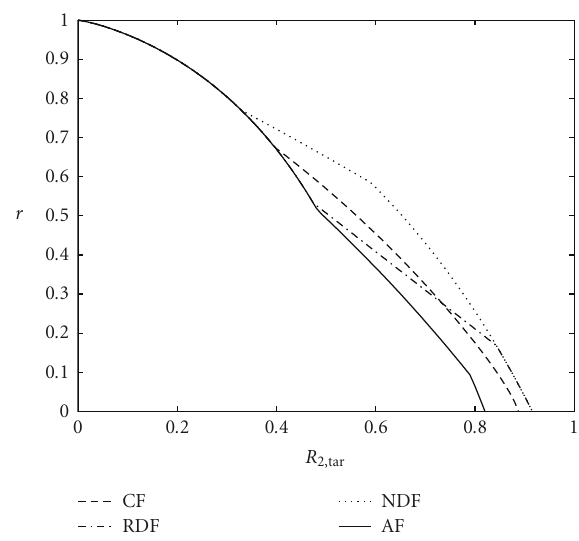
Figure 7: Achievable rate regions obtained via jointly optimal power and resource allocation in Scenario 2.